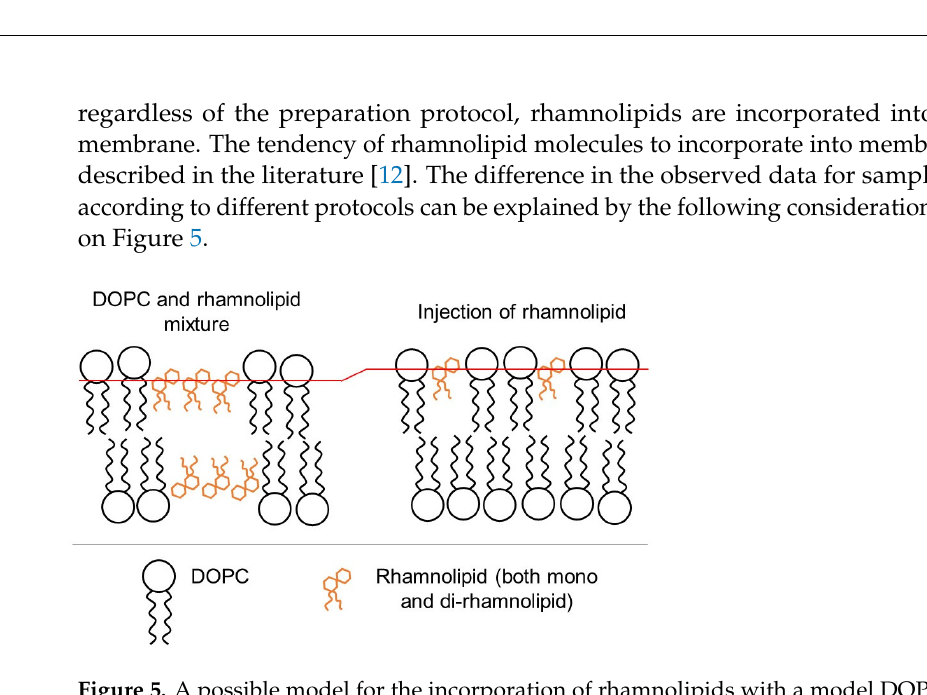
Figure 5. A possible model for the incorporation of rhamnolipids with a model DOPC membrane depending on the preparation